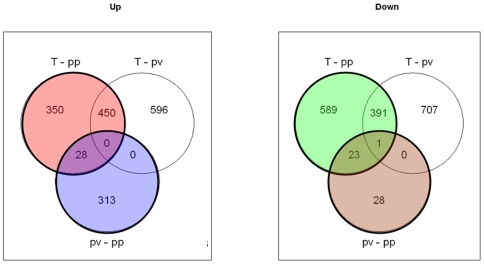
Venn diagram of significantly up- and down-regulated genes (n) in mesothelioma (T) versus normal parietal pleura (pp) and normal visceral pleura (pv) (P<0.05).828 genes are overexpressed (red) and 1004 genes are down-regulated (green) in T versus pp. 341 genes are overexpressed (blue) and 52 genes downregulated (brown) in pv versus pp.